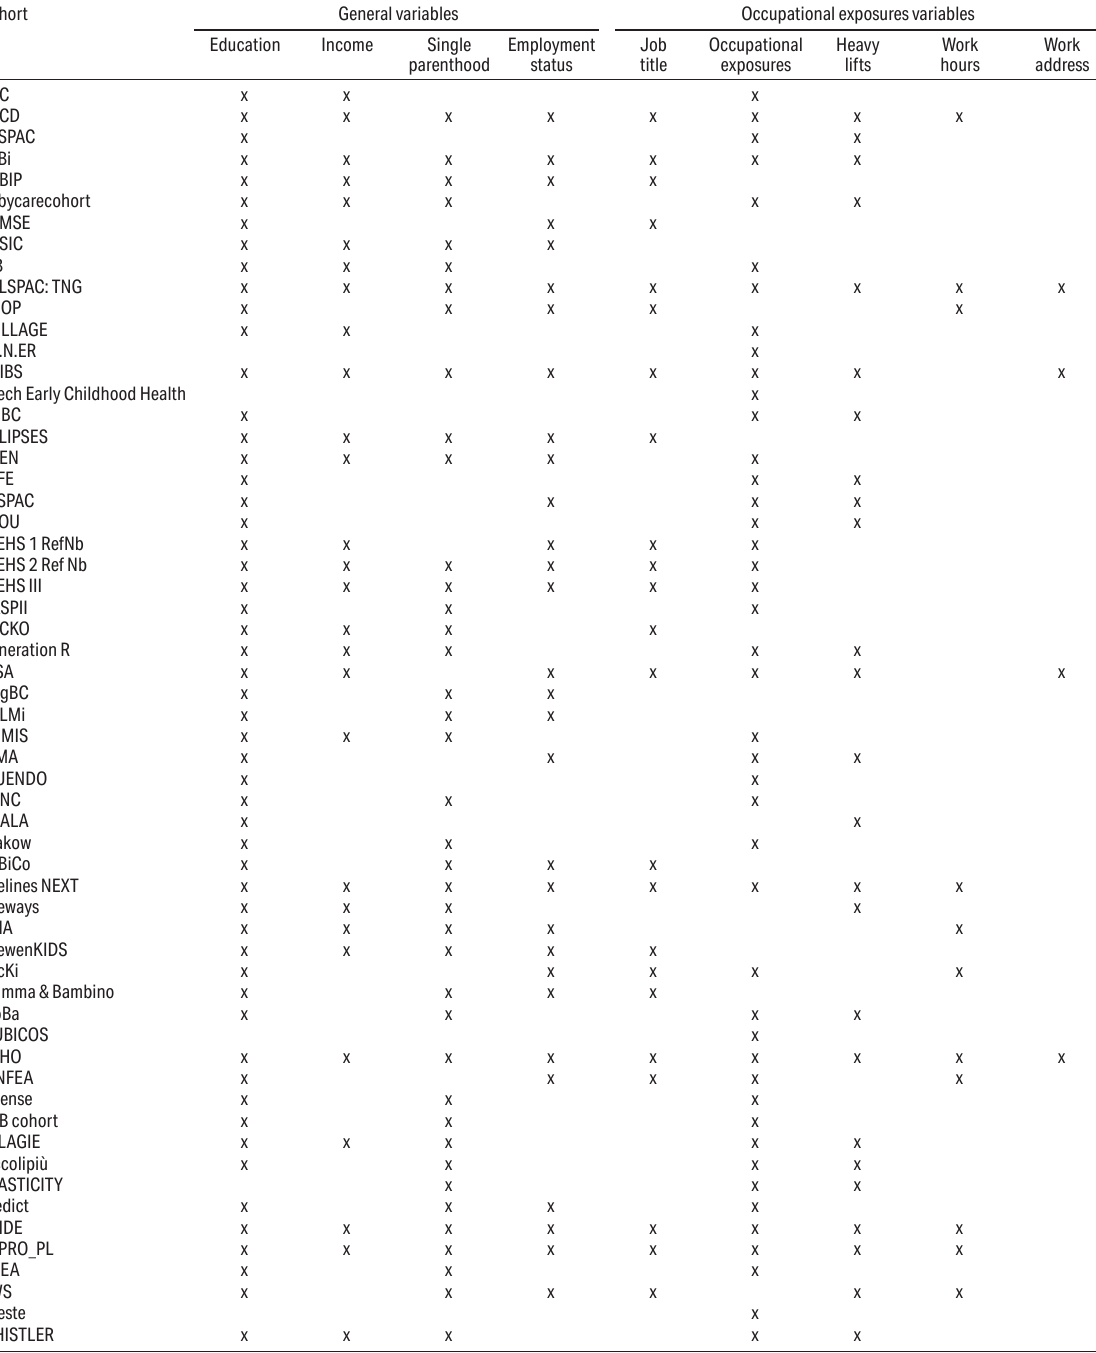
Table 1. Selected available information related to mothers’ work and socioeconomic status in 59 European birth cohorts (as reported in www. birthcohorts.net catalogue, accessed on 5 Feb